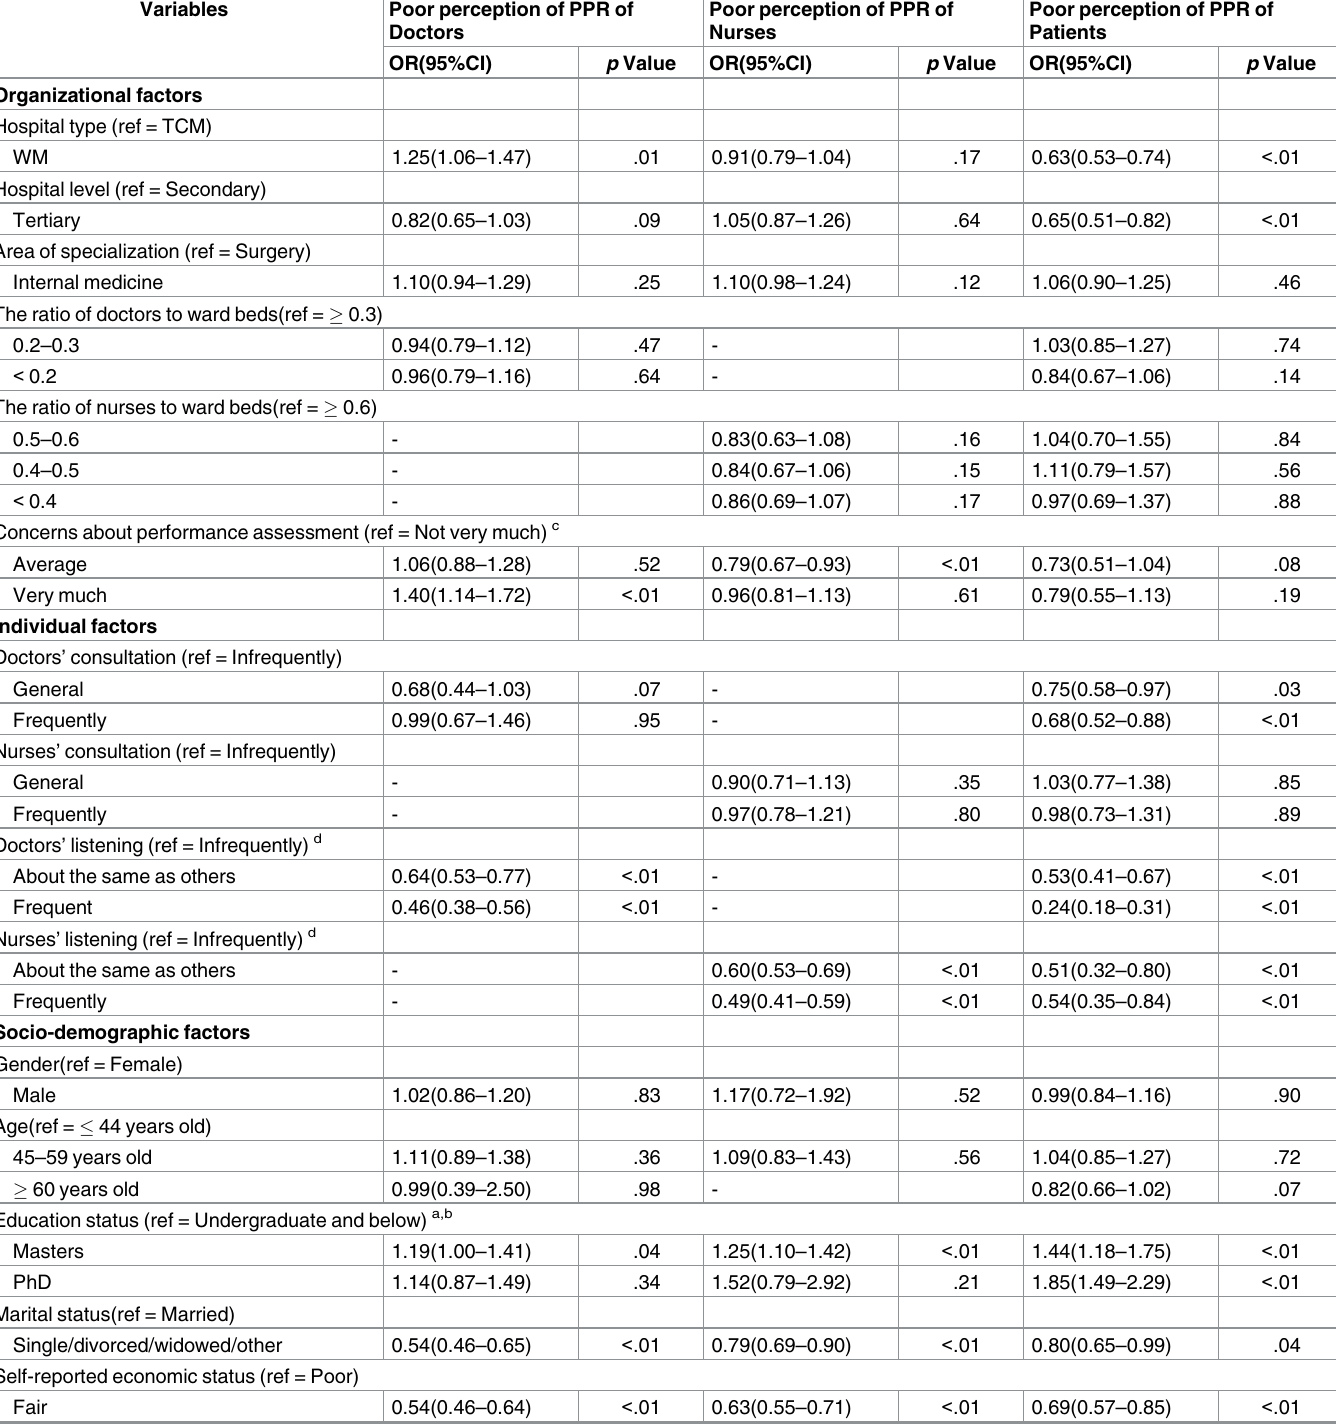
Table 3. Adjusted associations between predictor variables and the perception of patient-provider relationships of doctors, nurses and patients in